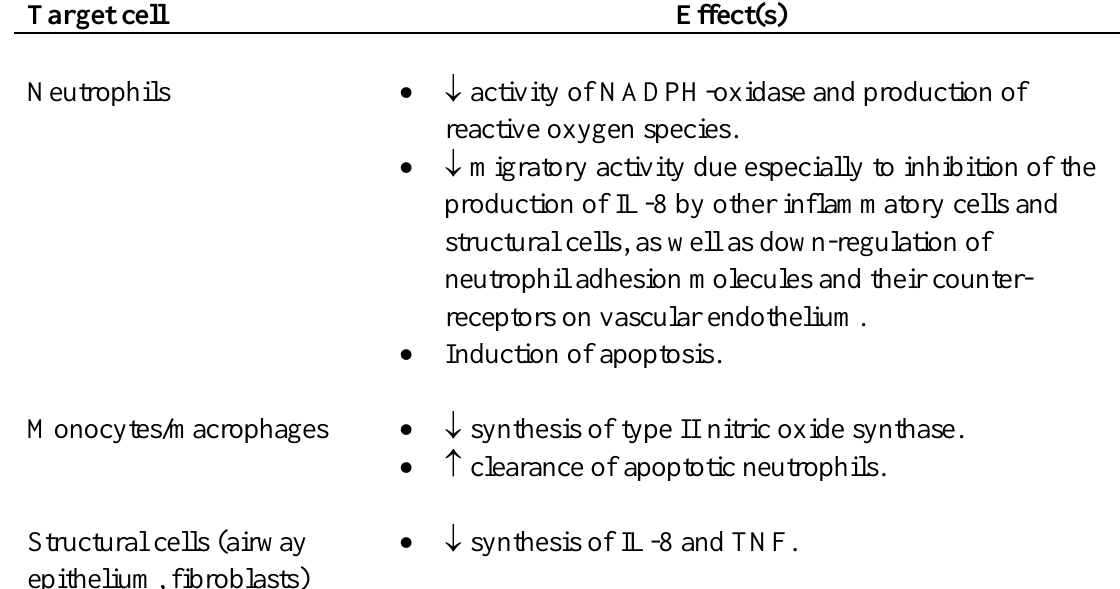
Table 2. Secondary anti-inflammatory activities of